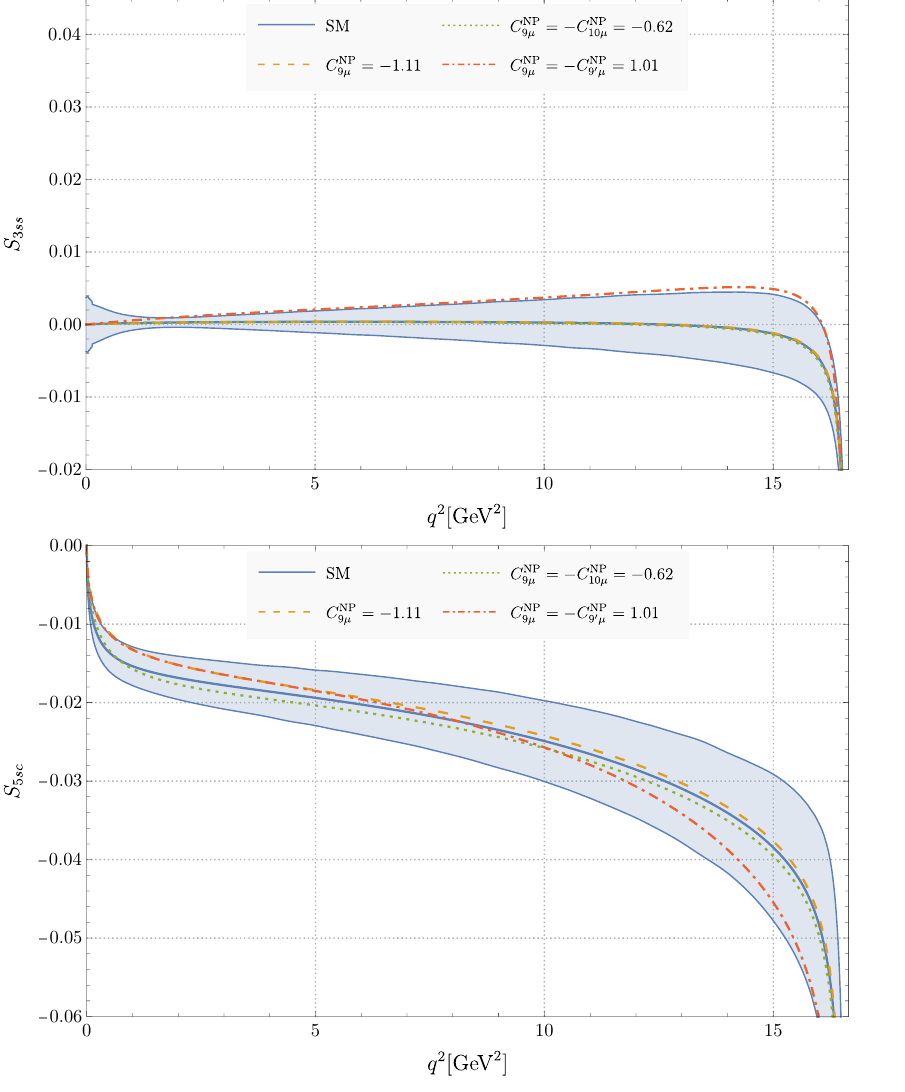
Figure 5 . Variation of S 3 ss (top) and S 5 sc (bottom) with respect to the dilepton invariant mass, in the case of the SM and three NP